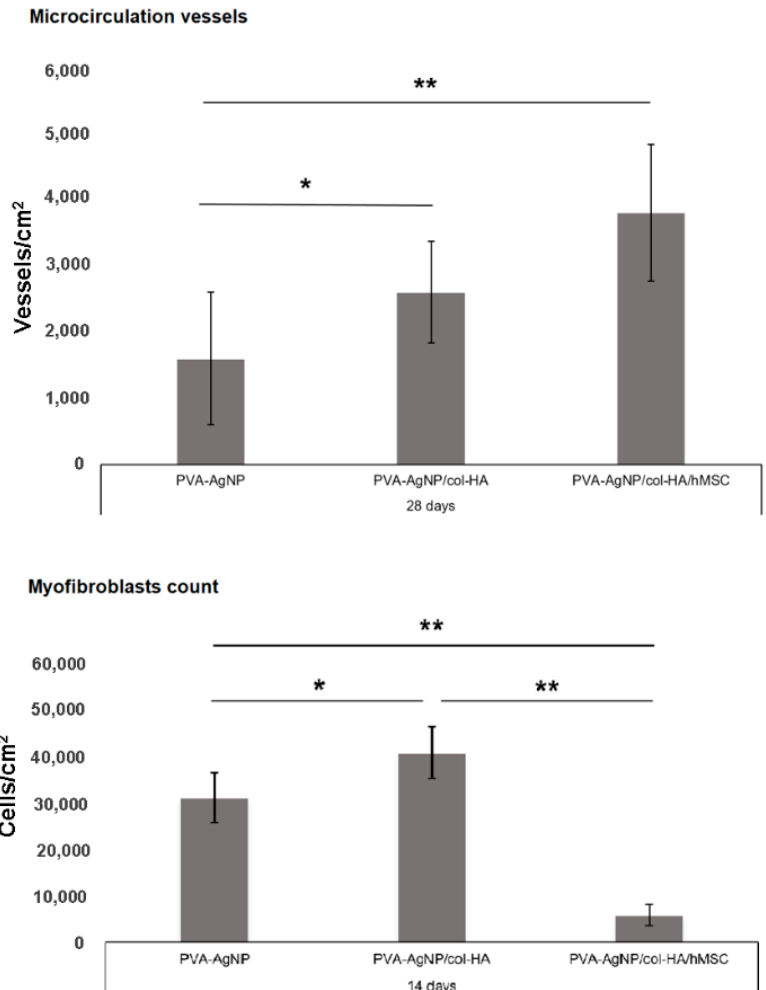
Figure 11. The quantification of microcirculation vessels and myofibroblasts were obtained from LSCM images labeled by α -SMA. The values are expressed as means and standard deviation of two samples for each group in an area of 1 cm 2 observed. Quite or very significant changes within samples are identified as (*) and (**), respectively.